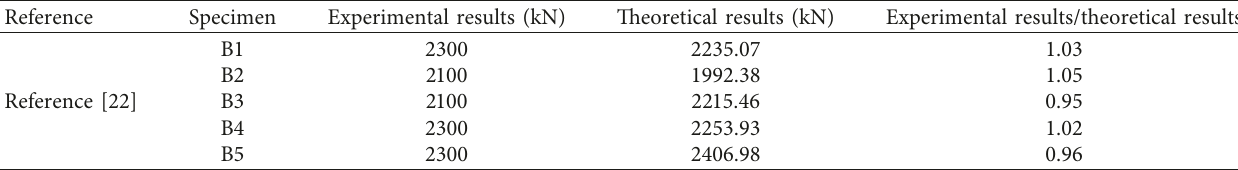
Table 6: Comparison of theoretical and experimental